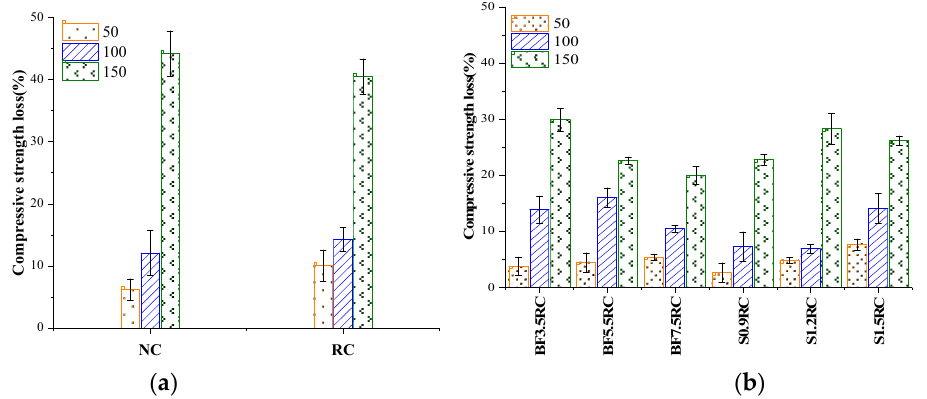
Figure 8. Change in compressive strength rate during the freeze–thaw cycle. ( a ) NC and RC. ( b ) Fiber-only recycled concrete.